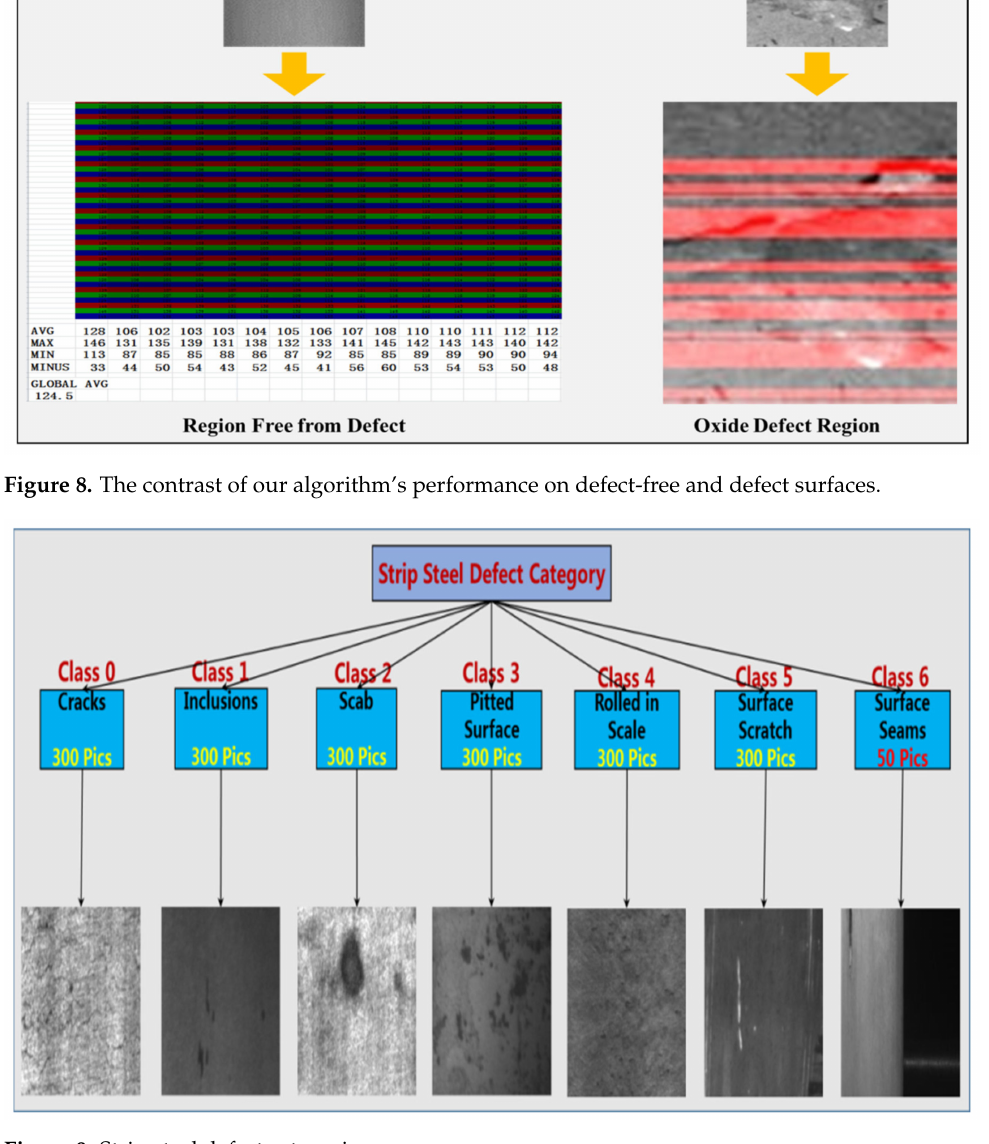
Figure 9. Strip steel defect categories. Table 1. Testing of Our Defect Feature Extraction